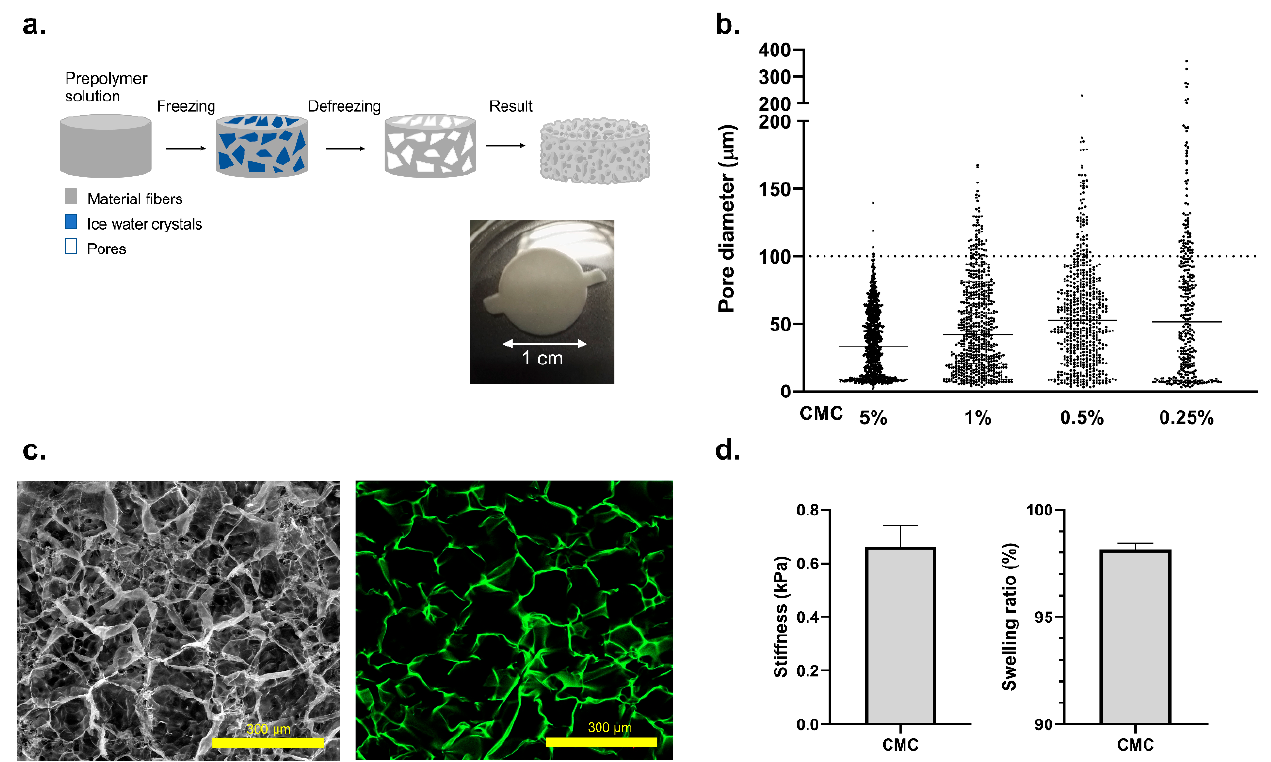
Figure 2. Cellulose-based cryogel fabrication and characterization. ( a ) General overview of the CMC cryogel fabrication protocol. Real images of CMC cryogel 0.5% ( w / v ) before islet seeding. Dimensions are 0.5 cm in height and 1 cm in diameter. ( b ) Pore diameter distribution of the cryogel at different CMC concentrations: 5%, 1%, 0.5%, and 0.25% ( w / v ), respectively. A total of 3 replicates and 20 images from 5 different depths were analyzed. ( c ) SEM image of the 0.5% ( w / v ) CMC cryogel condition after critical point drying. A confocal image of the same sample stained using 1 mM aminofluorescein (green) is on the right. ( d ) Characterization of the mechanical properties of the 0.5% ( w / v ) CMC cryogel. Young’s modulus of 0.67 ± 0.1 KPa was obtained by compression assays with 5 N load cell. Data corresponds with 3 compressions per cryogel and n = 3. The swelling ratio was determined obtaining values of 98.1% ± 0.3% for replicates n = 3 and 3 measures per cryogel. Values are expressed as mean ± SD: p < 0.05.